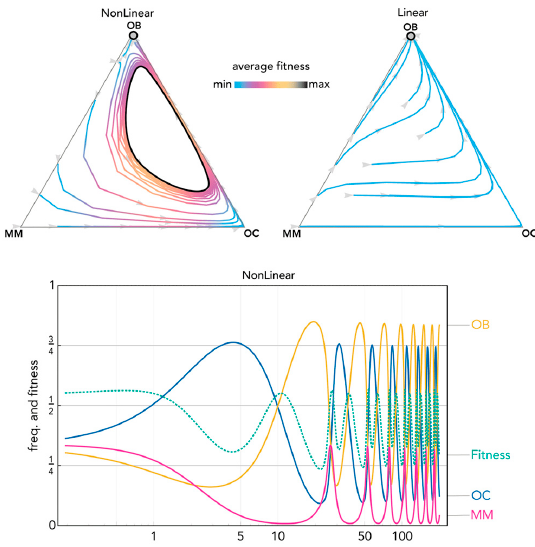
Figure 8. Nonlinear benefits can lead to a limit cycle. The distance from each vertex is inversely proportional to the frequency of each type. Arrows show the direction of the dynamics; colors show the average fitness of the population. N = 20; c OC = 1.2; c OB = 1.0; c MM = 1.8; B OC,OC = 1.1; B OC,OB = 1.1; B OC,MM = 1.1; B OB,OC = 0.95; B OB,OB = 1.1; B OB,MM = 1.5; B MM,OC = 1.8; B MM,OB = − 0.35; B MM,MM = 0.35; h OC,OC = 0; h OC,OB = 0; h OC,MM = 0; h OB,OC = 0; h OB,OB = 0; h OB,MM = 0; h MM,OC = 0.2, h MM,OB = 0.2; h MM,MM = 0.2. Nonlinear: s OC,OC = 4; s OC,OB = 4; s OC,MM = 40; s OB,OC = 4; s OB,OB = 4; s OB,MM = 4; s MM,OC = 6; s MM,OB = 6; s MM,MM = 1000; Linear: s i,j → 0.